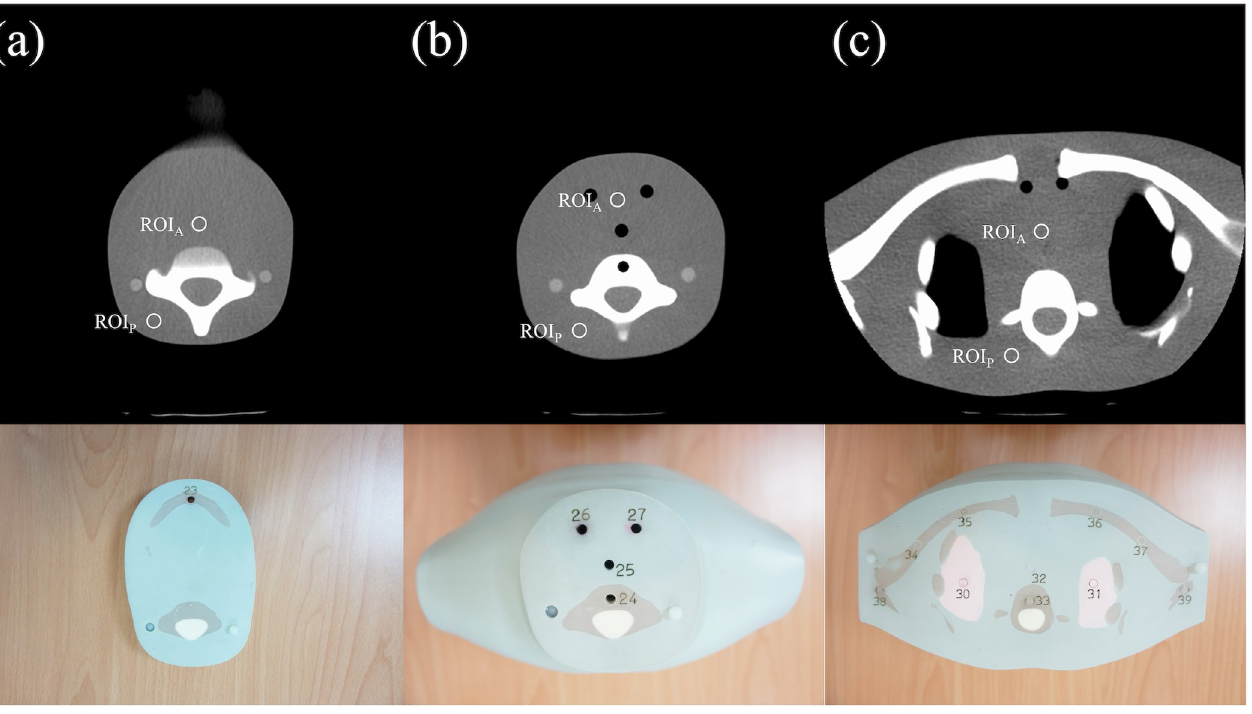
PLOS ONE | https://doi.org/10.1371/journal.pone.0259772 November12,